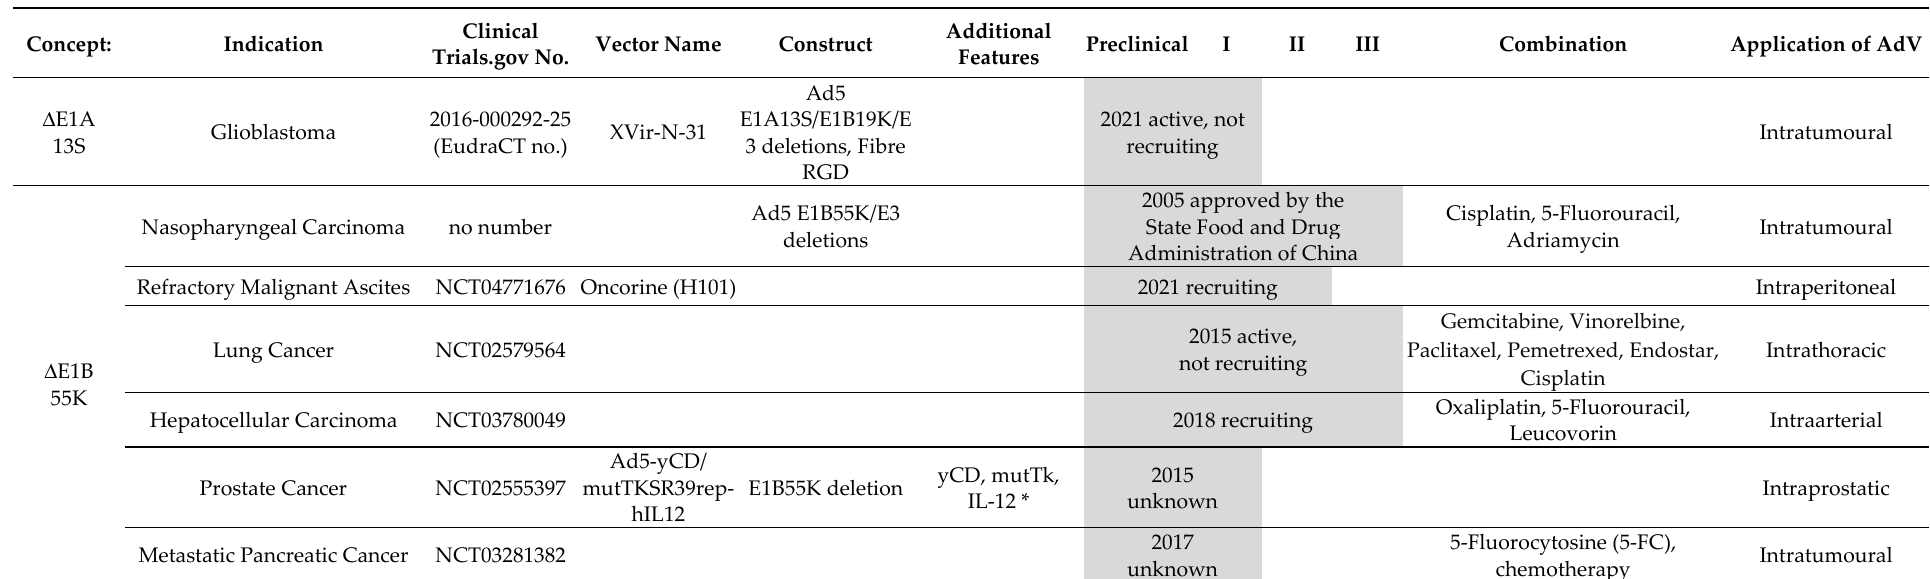
Table 4. Clinical trials using oncolytic adenoviruses with E1A13S or E1B55K deletions.